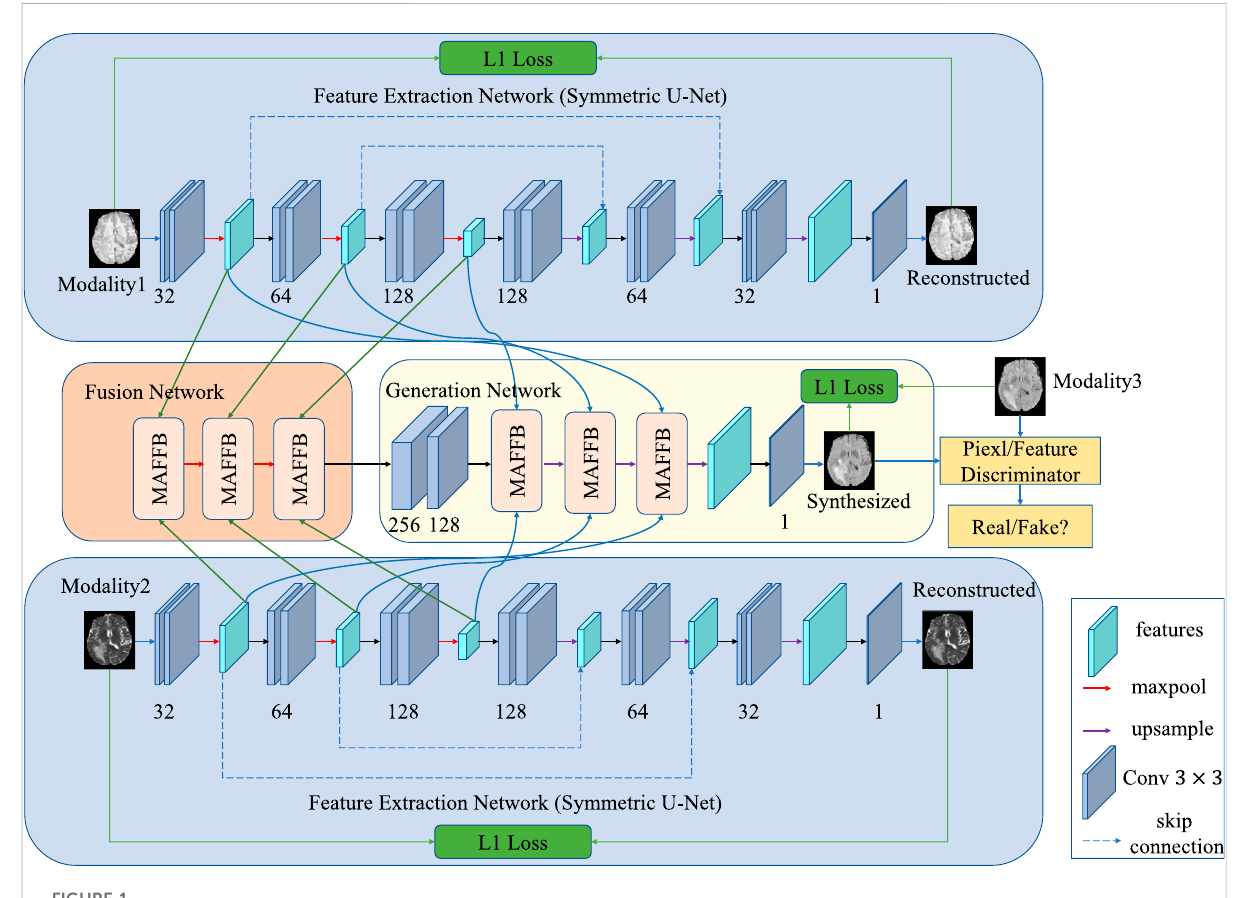
FIGURE 1 Pipeline of our proposed method. Our model comprises three main parts: the feature extraction network (a symmetric U-net pre-trained with self-supervised learning), the feature fusion network, and the GAN-based generation network. The feature extraction network learns the unique information of different modalities, while the fusion network aims to learn the common properties of multimodal images. The GAN-based generation network includes a generator and two discriminators. One discriminator distinguishes from the pixel-wise aspect, and the other discriminator considers the feature-level.